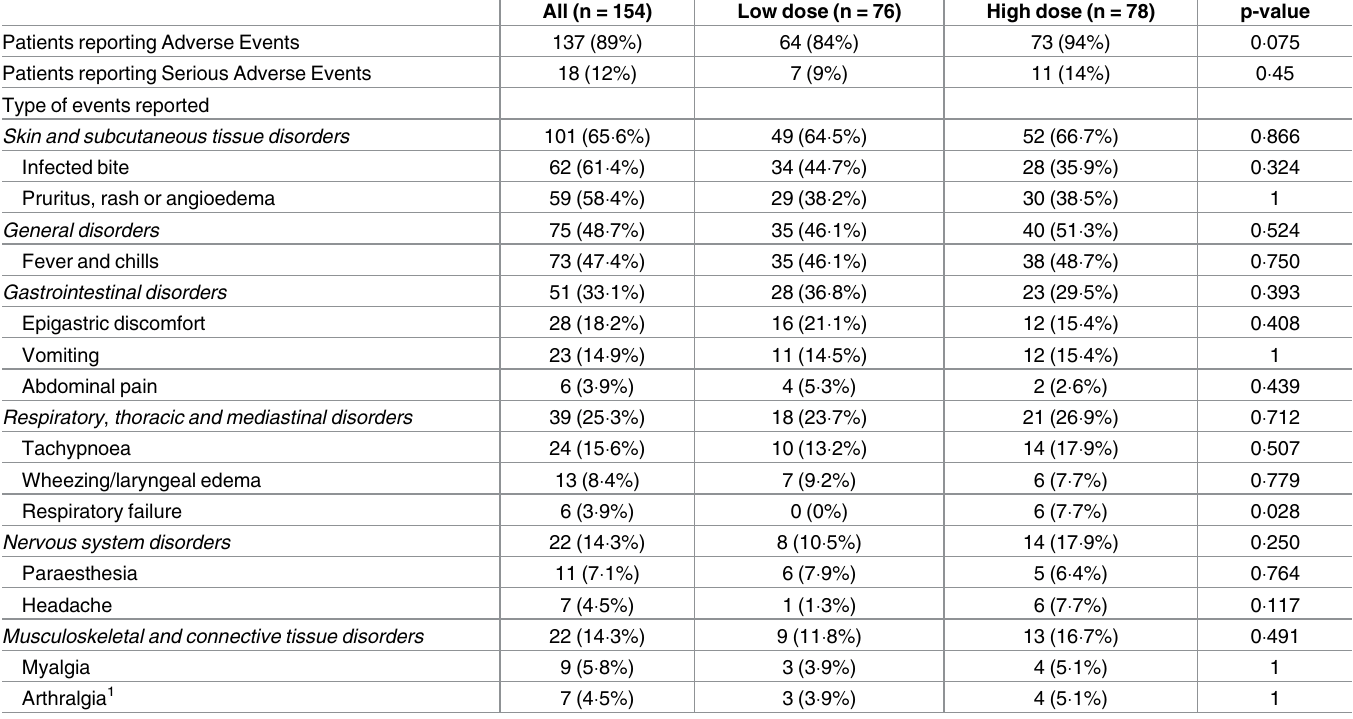
Table 4. Safety endpoints. Figures are numbers of participants (percentage) unless stated